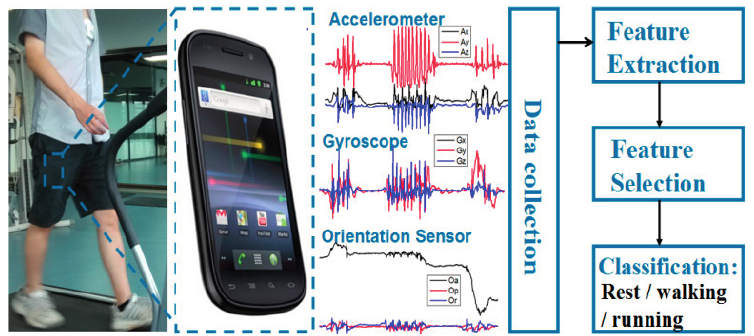
Figure 5. The block diagram of the physical activity recognition